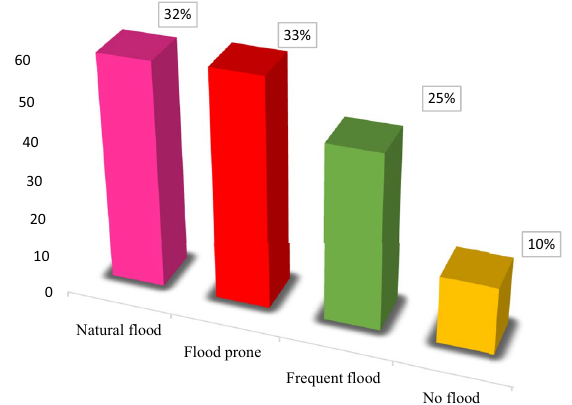
Fig. 2 Percentages of flood